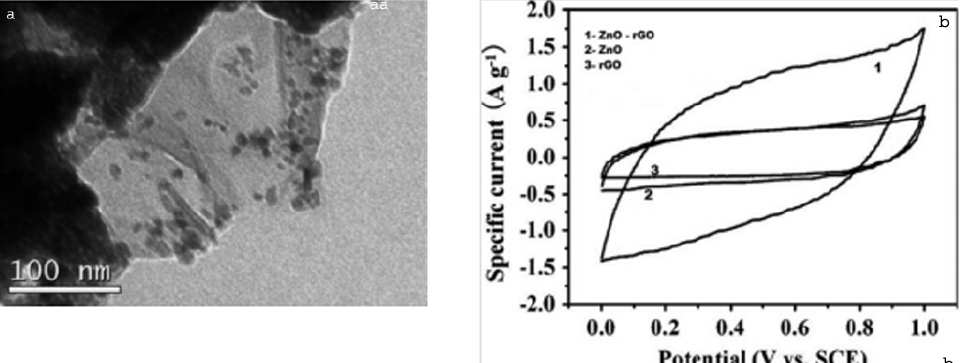
Fig. 5. (a) Schematic of the circuit for two-probe measurement; (b) and (c) I-V characteristics of the as synthesized films of ZnO NPs and rGO-ZnO NPs on SiO permission from Ref [53]. Copyright 2016 American Institute of